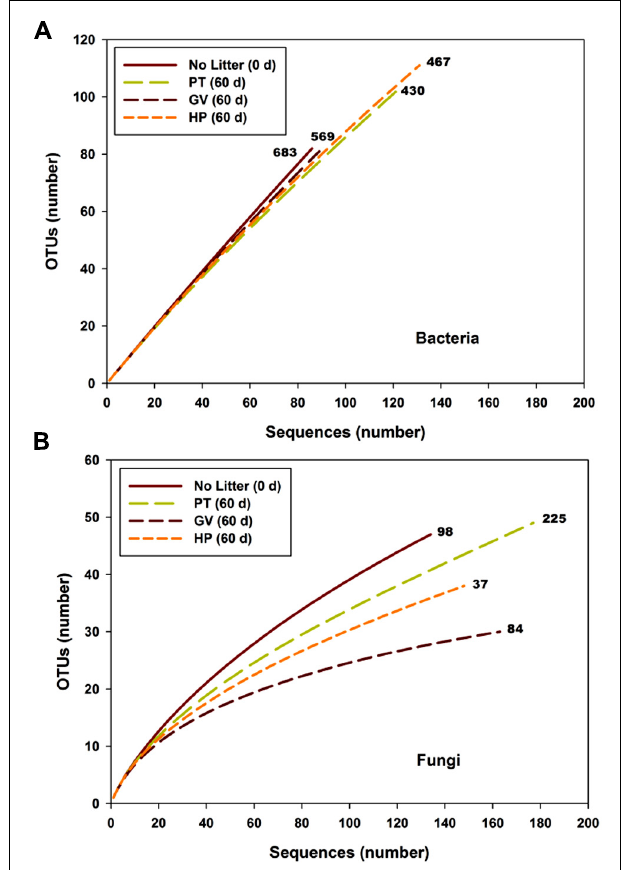
FIGURE 2 | Rarefaction curves for bacterial (A) and fungal (B) sequences vs. OTUs found in microcosms with soil and leaf litter from Populus tremuloides . Curves are shown for soil before incubation (0 d) without added litter (Control), and soil from microcosms incubated for 60 d, with litter either from parental type (PT) saplings or transgenic poplar possessing either a simple GUS vector (GV) or higher expression of proanthocyanidins (HP). Numbers next to curves indicate the Chao richness